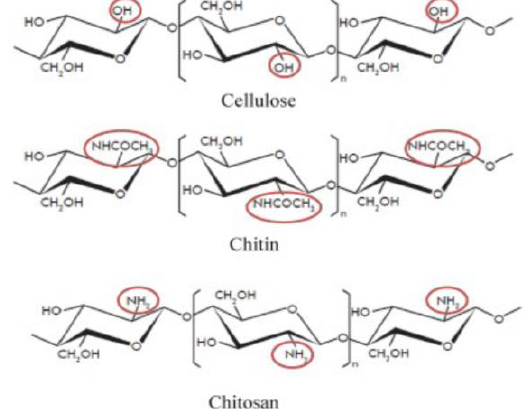
Figure 6. Cellulose, Chitin and Chitosan compared.